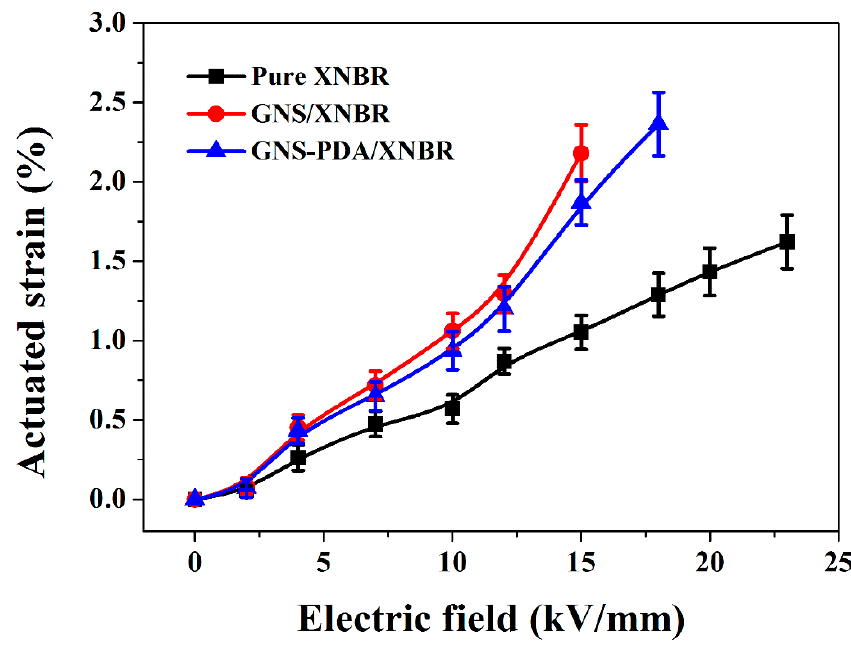
Figure 7. Dependence of actuated strain on electric field for pure XNBR, GNS/XNBR composite, and GNS-PDA/XNBR composite.